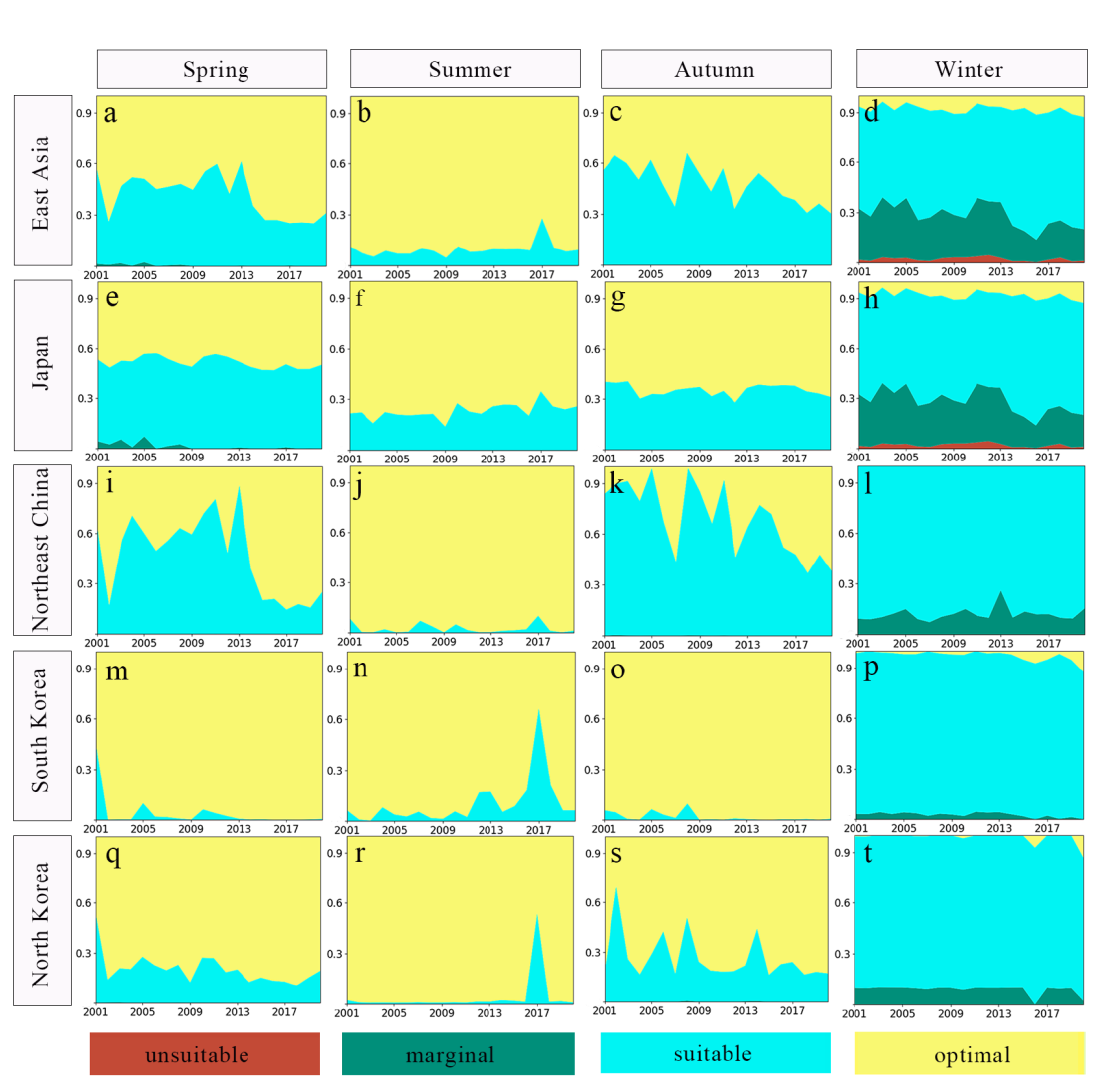
Figure 6. Bio-geophysical suitability maps of East Asia from 2001 to 2020 in winter.